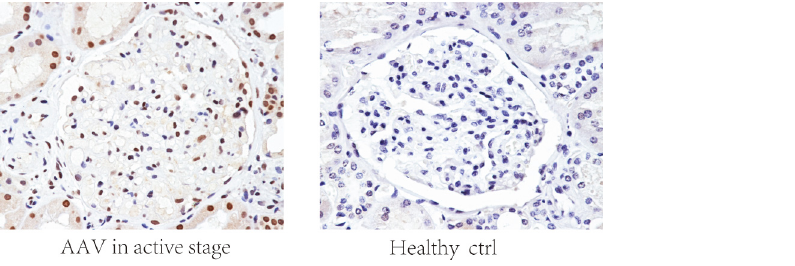
Fig 3. Renal NETs level of AAV patients and healthy control.